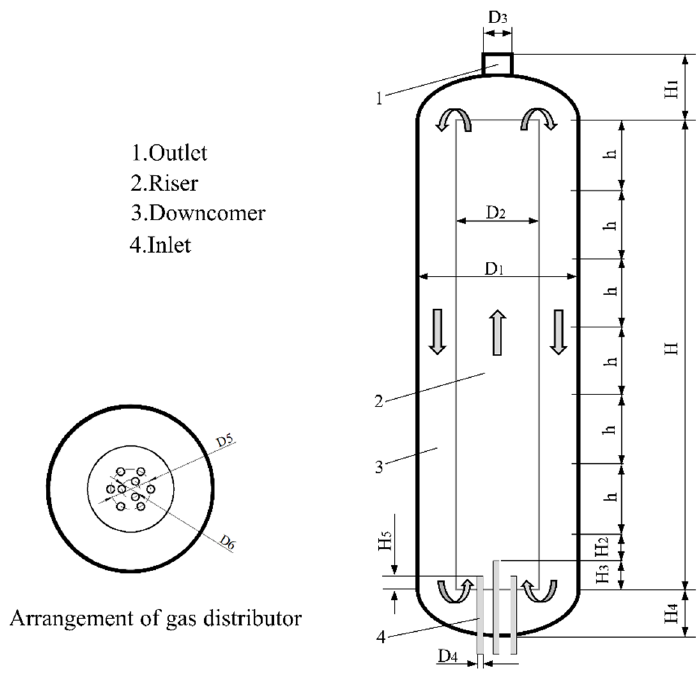
Figure 1. Schematic of internal loop airlift column. Table 1. Parameters of airlift column.